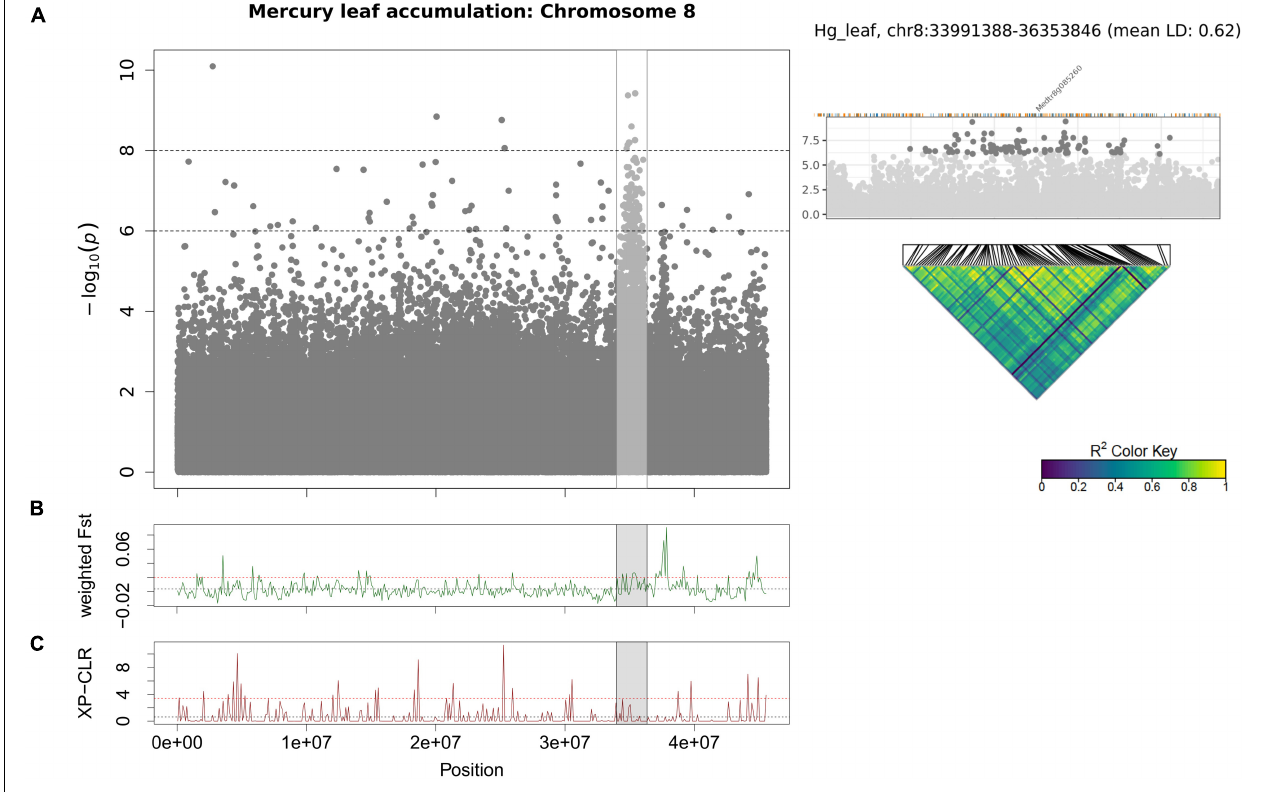
FIGURE 6 | Manhattan plot of Hg leaf accumulation for chromosome 8 using GEMMA (A) . Each point represents a SNP, the x -axis signifies the position on the chromosome while the y -axis is the –log 10 of the p -value. The Cd RRG phenotype was log 2 transformed to normalize the data prior to running the GWAS. The GWAS region is highlighted in gray the F st (B) and XP-CLR (C) sliding window (100 kb windows) analyses. The x -axis represents the chromosomal position, the y -axis the F st or XP-CLR-value of the window at the corresponding position. Higher F st indicates population differentiation, higher XP-CLR indicates the presence of a selective sweep. The dashed black line represents the mean F st or CLR-values for the chromosome, the dashed red line represents windows ≥ 5% of the highest F st or CLR-values for the